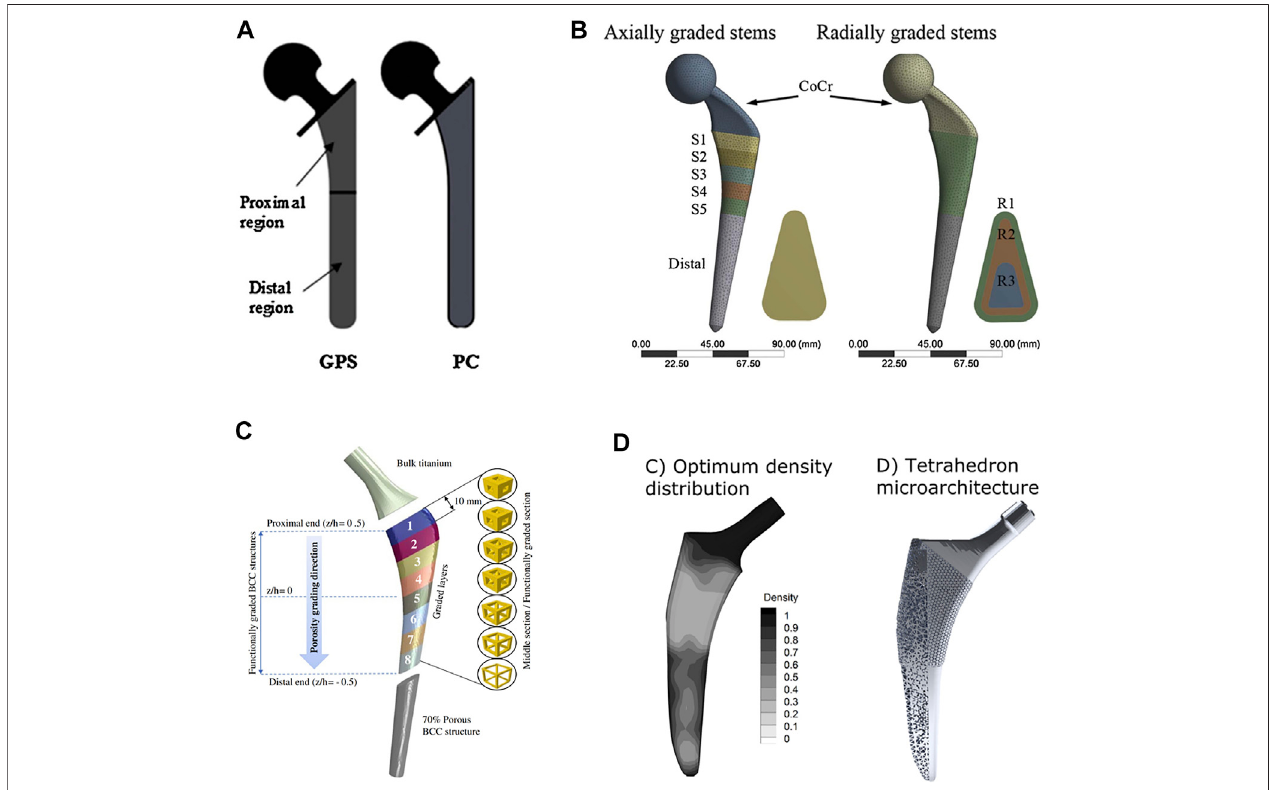
FIGURE 9 | Four types of functionally graded femoral stems: (A) A two-step gradient stem designed by Hazlehurst et al. GPS: porous stem with axially graded stiffness, PC: porous stem with radial graded stiffness (Hazlehurst et al., 2014b); (B) Multi-level gradient stem designed by Limmahakhun et al. (2017a); (C) Smooth gradientstemdesignedaccordingtoasigmoidfunctiondesignedbyAlkhatibetal.(2019b); (D) Stemusinganoptimum distribution ofrelativedensitytominimizestress shielding, designed by Arabnejad et al. (2017).